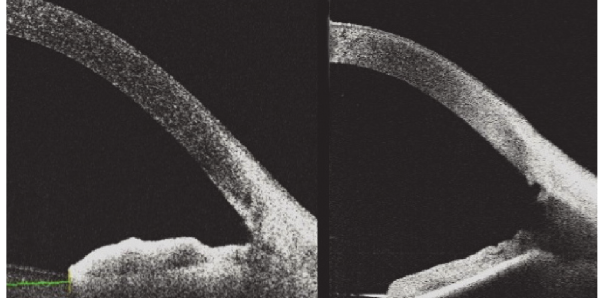
Figure 3: A cross-sectional OCT image of the nasal angle following combined Trabectome-cataract surgery. This frame-averaged image shows that the posterior trabecular meshwork has been removed, leaving a wide trabecular cleft.